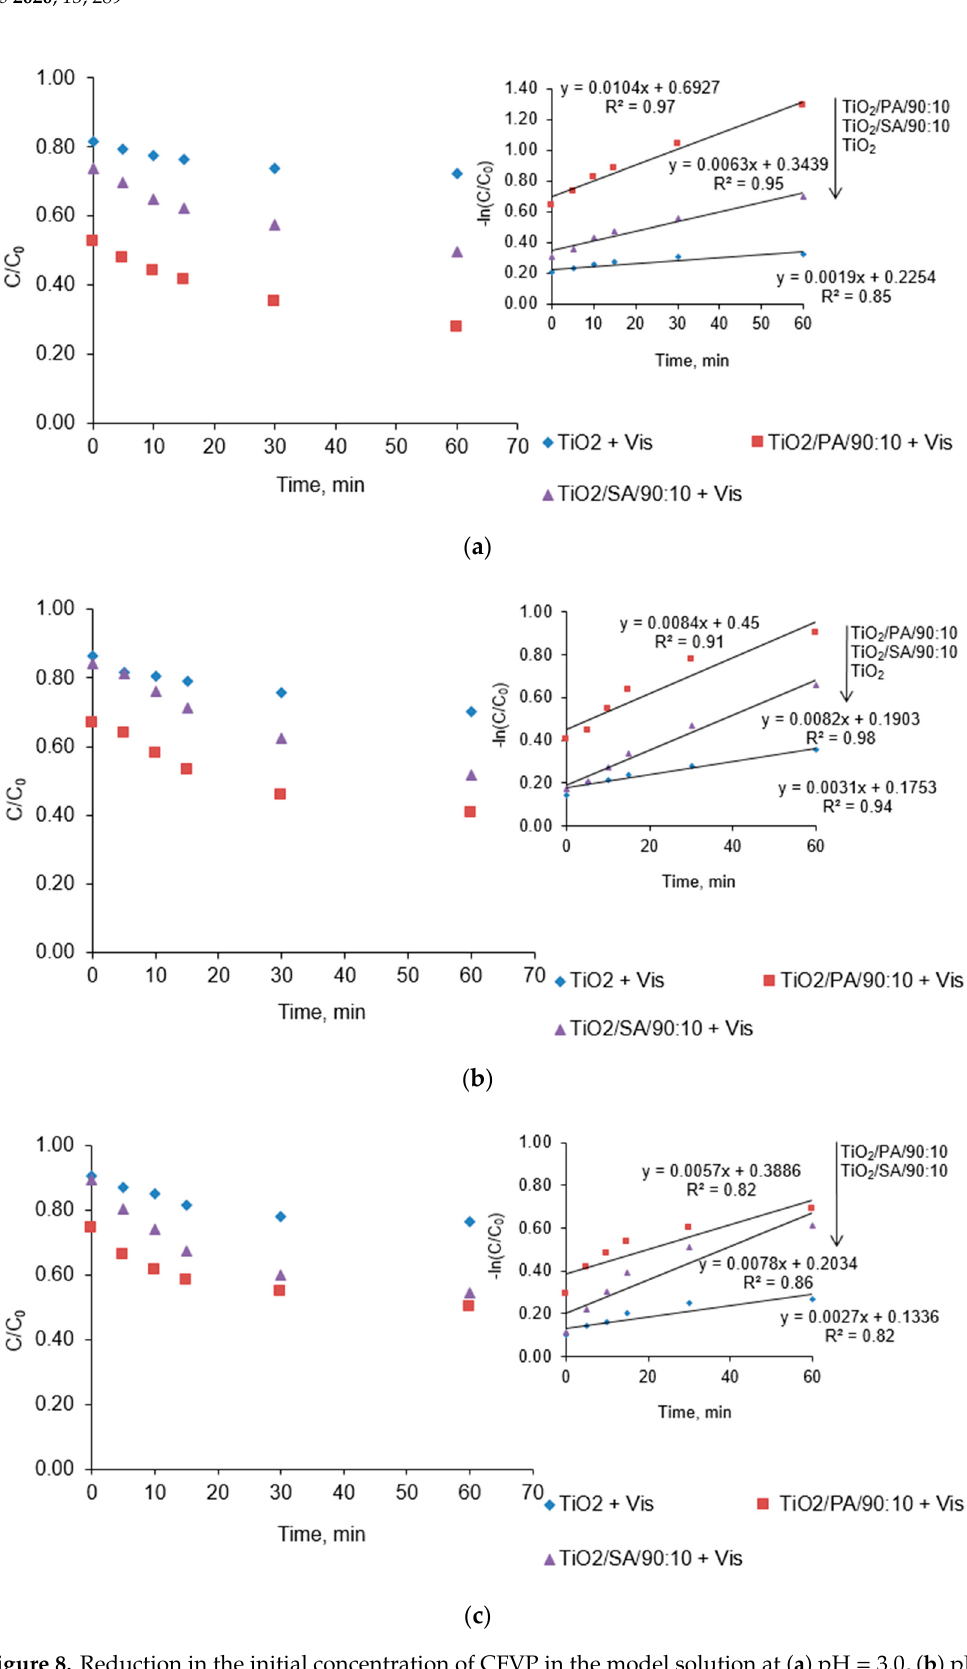
= 1.0 mg / L; D = 50.0 mg / L; V = 500.0 mL; t = c r sor 0